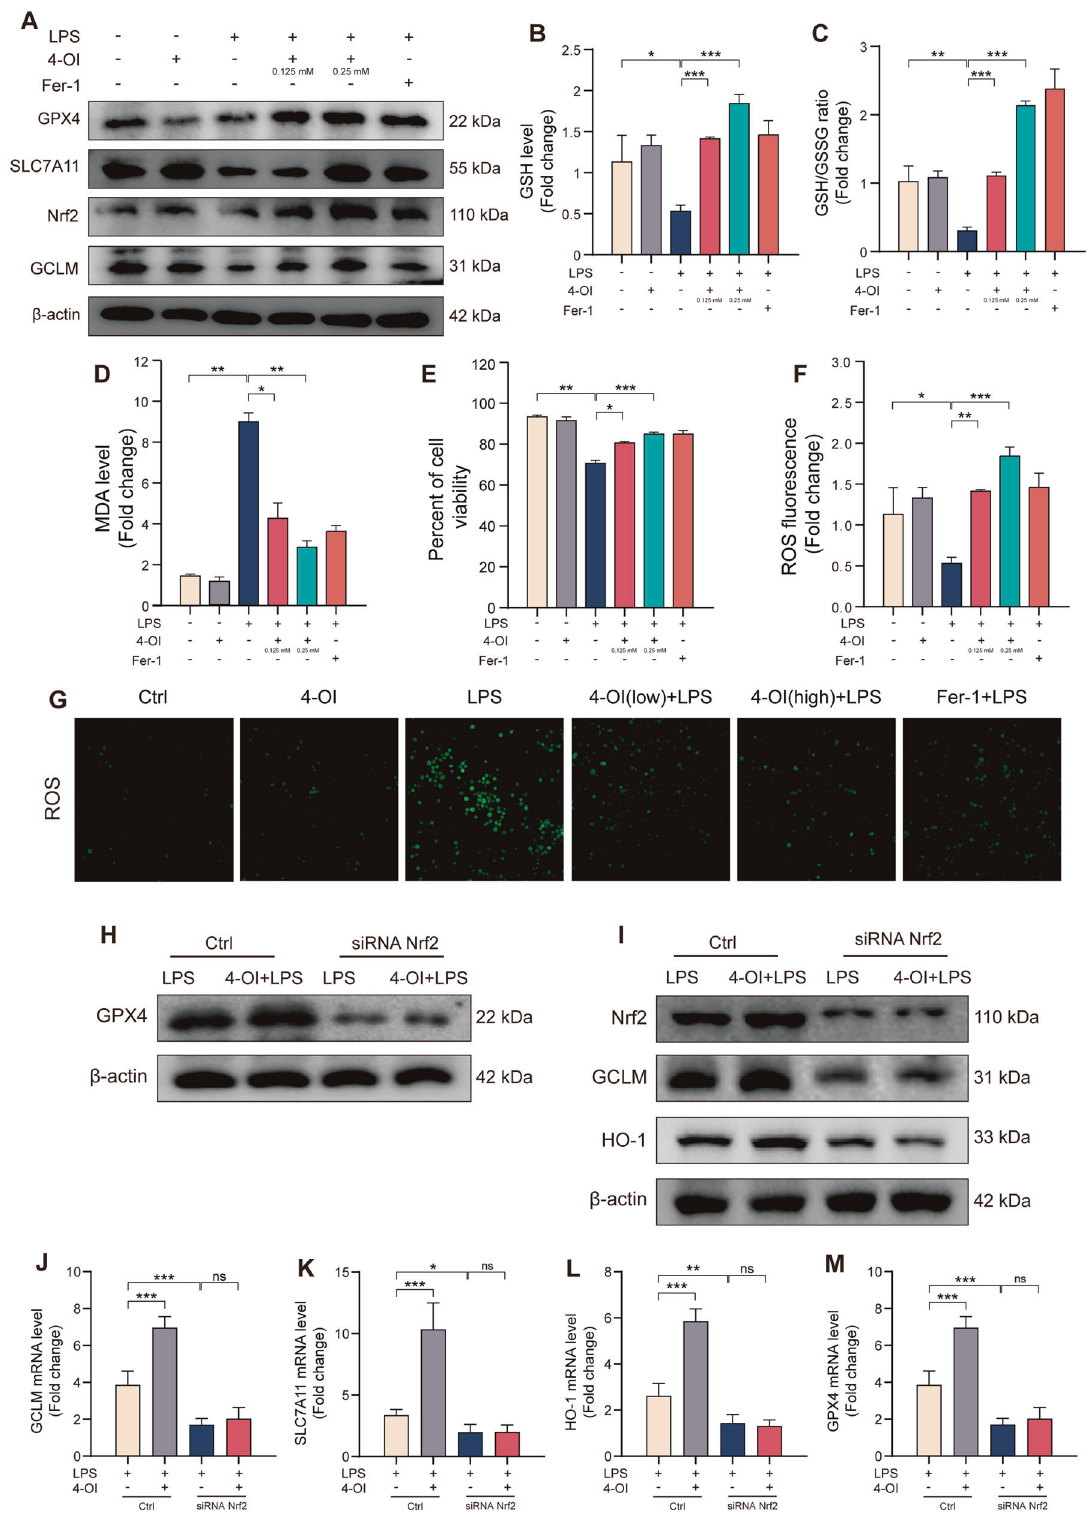
Fig. 4 4-OI inhibits LPS induced ferroptosis through Nrf2-dependent pathways in THP-1 cell. A After induced into macrophage-like state through 100 ng/ml PMA (6 h), THP-1 cells were harvested following 4-OI pretreatment (12 h) and LPS (3 h), immunoblotted for the GPX4, Nrf2, GCLM and SLC7A11 level. B , C Relative level of GSH and GSH/GSSG ratio in THP-1 cell lysates. D Relative MDA level in THP-1 cell lysates. E After 4-OI pretreatment (12 h) and LPS (3 h), Trypan Blue staining was used to determine THP-1 cell viability ( n = 6). F , G Representative images of fl uorescence probe for ROS and its quantitative results in THP-1 cell ( n = 6). H , I Western blots for GPX4, Nrf2, GCLM and HO-1 in THP-1 cells transfected with siRNA against Nrf2. J-M Relative mRNA levels of GPX4, Nrf2, GCLM and HO-1 in THP-1 cells with or without si-Nrf2 transfection ( n = 6). (Data are presented as Mean ± SD * p < 0.05, ** p < 0.01, *** p < 0.001).